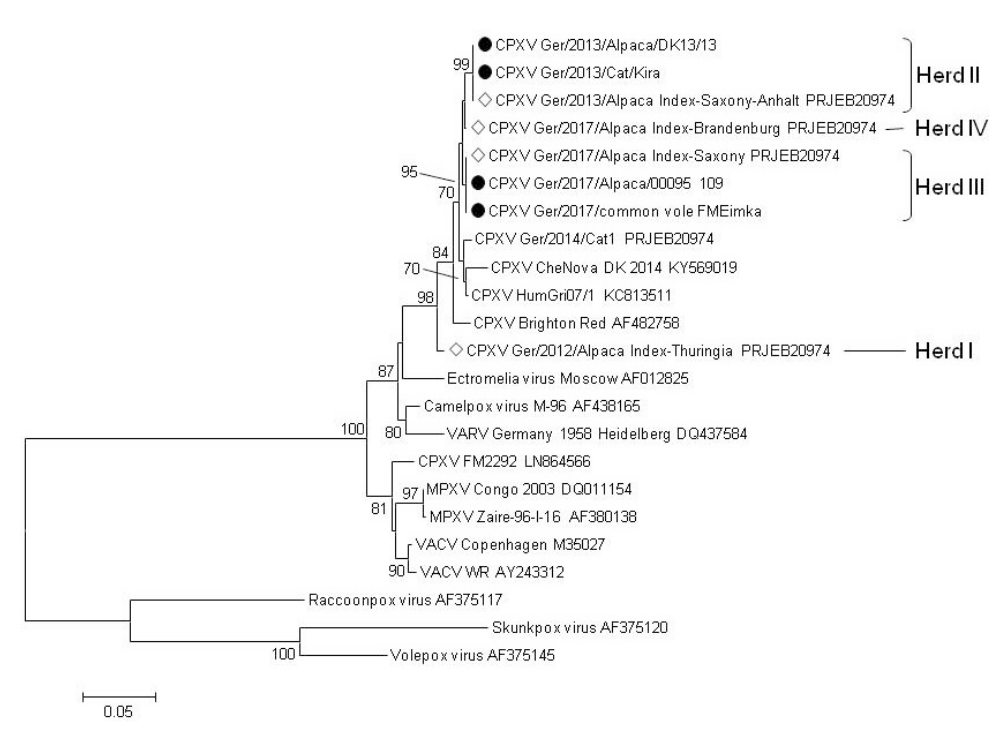
Figure 2. Evolutionary relationship of taxa based on the nucleotide sequence of the hemagglutinin gene. The evolutionary history was inferred using the Neighbor-Joining method [37]. The optimal tree with the sum of branch length = 0.99468564 is shown. The percentage of replicate trees in which the associated taxa clustered together in the bootstrap test (1000 replicates) are shown at the bifurcations [38]. The tree is drawn to scale, with branch lengths in the same units as those of the evolutionary distances used to infer the phylogenetic tree. The evolutionary distances were computed using the Maximum Composite Likelihood method [39] and are in the units of the number of base substitutions per site. The analysis involved 23 nucleotide sequences. All positions containing gaps and missing data were eliminated. There was a total of 629 positions in the final dataset. Evolutionary analyses were conducted in MEGA6 [36]. Abbreviations used are: CPXV, cowpox virus; MPXV, monkeypox virus; VACV, vaccinia virus; VARV, variola virus. Novel sequences generated in this study are indicated by black circles. White diamonds show CPXV isolates from alpacas previously fully sequenced [12].